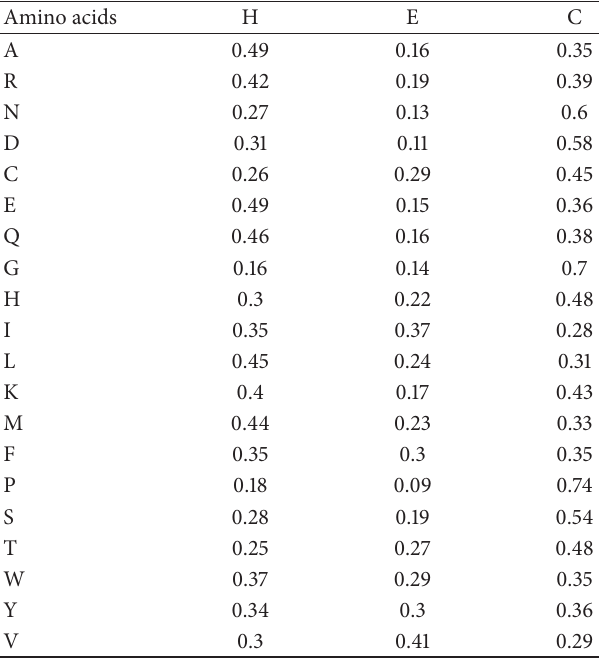
Table 3: Hydrophobic values of amino acids.